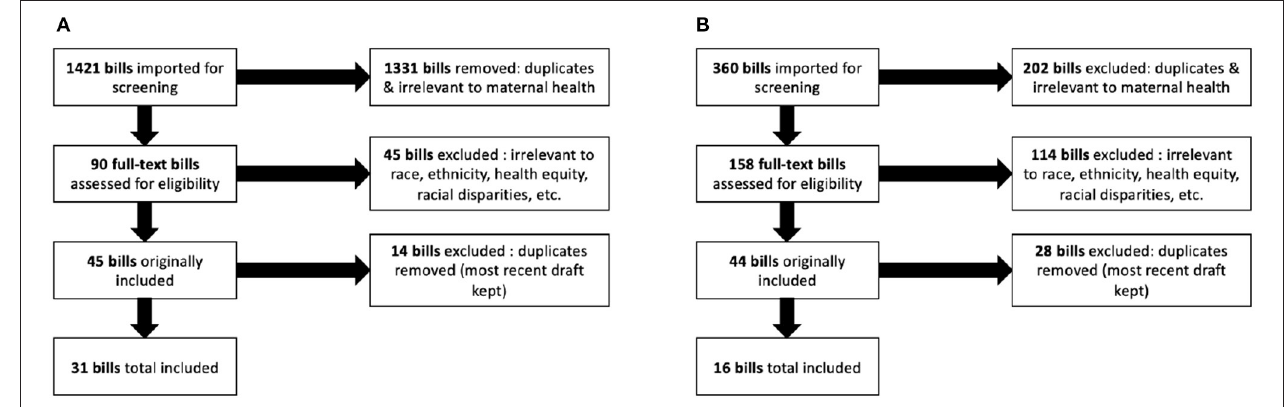
FIGURE 1 | Flow chart of inclusion of bills in review. Panel (A) shows the national bills inclusion process and panel (B) shows the Massachusetts state-level bill inclusion